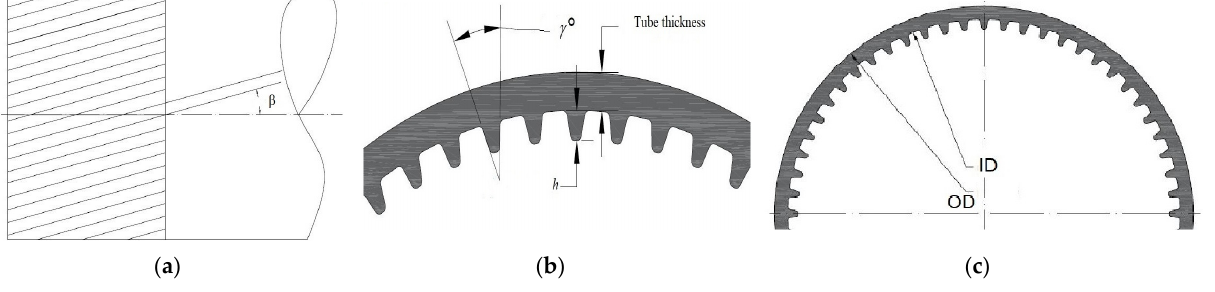
Figure 7. Different geometrical terms related to micro-fin tube geometry; ( a ) = helix angle, ( b ) = Apex angle, tube thickness, and fin height, and ( c ) = Inner and outer diameters.